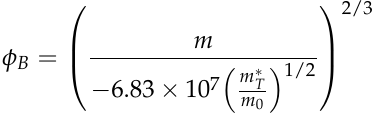
Figure 6. ( a ) EL intensity as a function of voltage and ( b ) EL intensity as a function of the current density of the PIN device in FB and the PIN + N device in FB and RB.